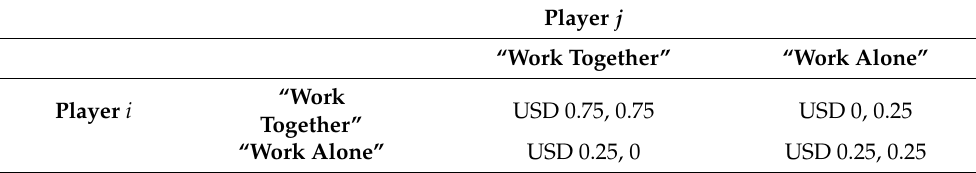
Table 1. Collaboration-framed Stag